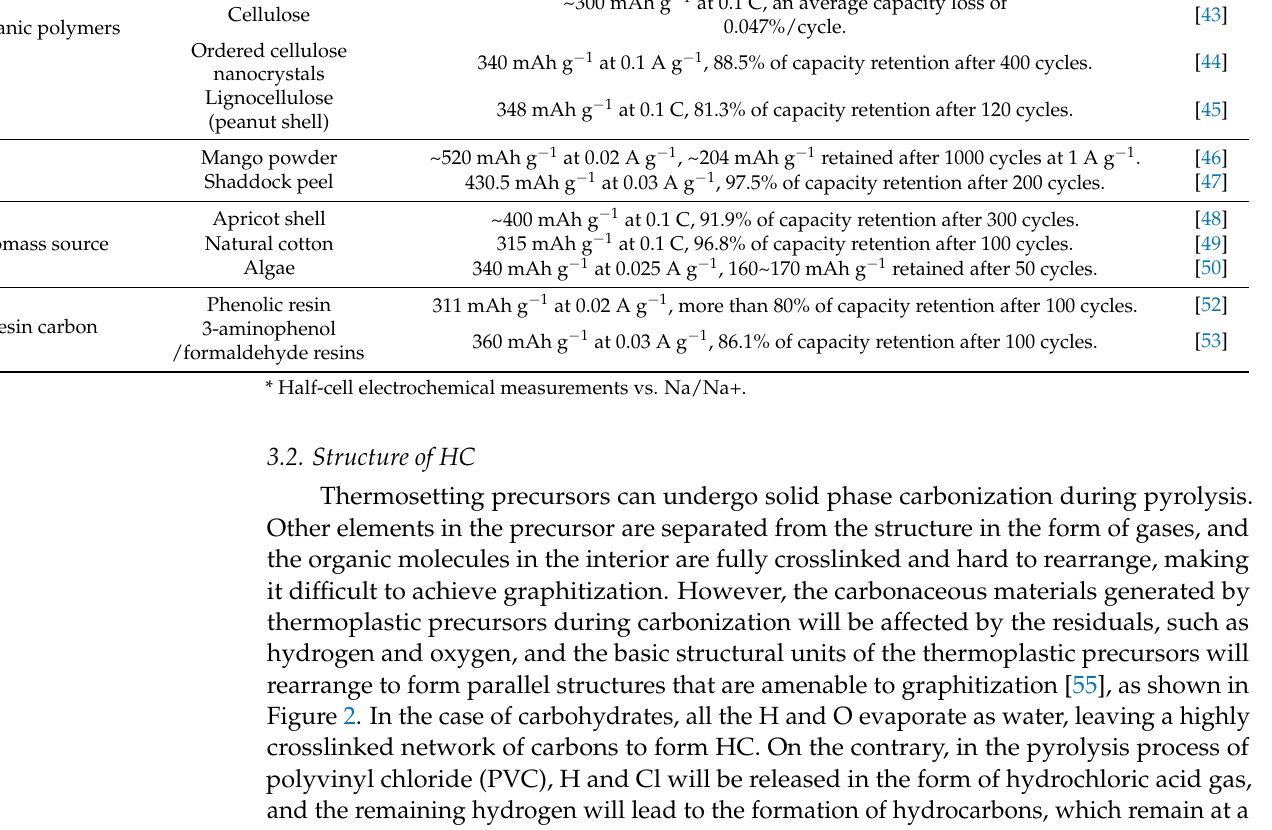
Organic polymers